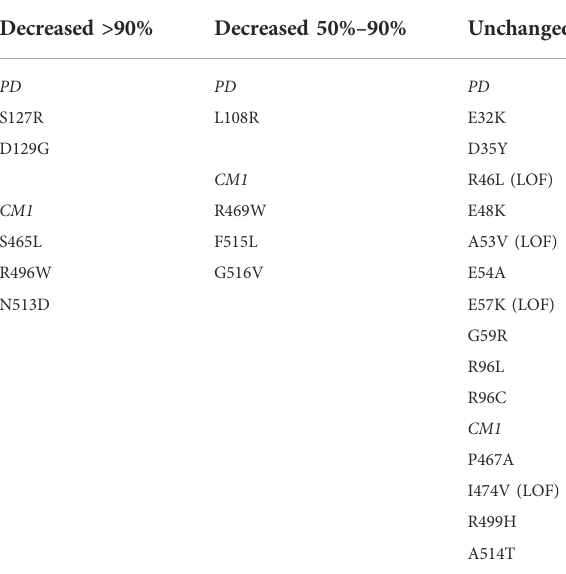
TABLE 1 Effect on LDL binding in vitro of PD- and CM1-localized PCSK9 mutations associated with total cholesterol and LDL-C. All mutations are associated with hypercholesterolemia and designated as GOF unless indicated. Loss-of-function (LOF) mutations are associated with hypocholesterolemia. Selected mutations are described in references herein and/or listed in the NCBI